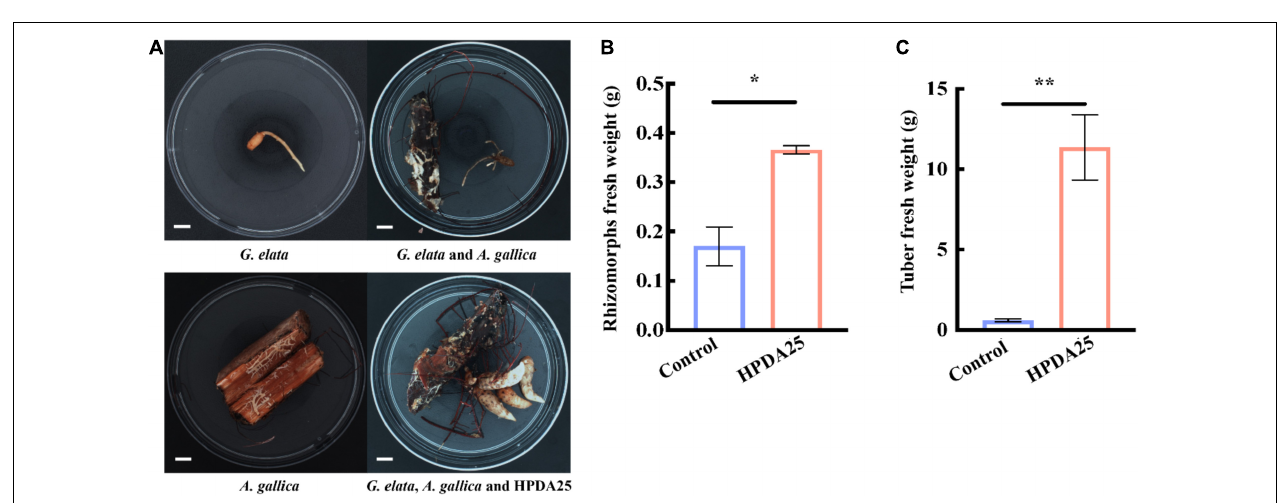
FIGURE 3 | Rahnella spp. co-cultured with A. gallica . (A) A. gallica co-cultured with three Rahnella spp. (B) Rahnella spp. increased rhizomorph’s fresh weight, growth rate, branching, and extracellular laccase activity of A. gallica . Control, A. gallica cultured alone in medium. Data are shown as means ± SE. * P < 0.05; *** P < 0.001.